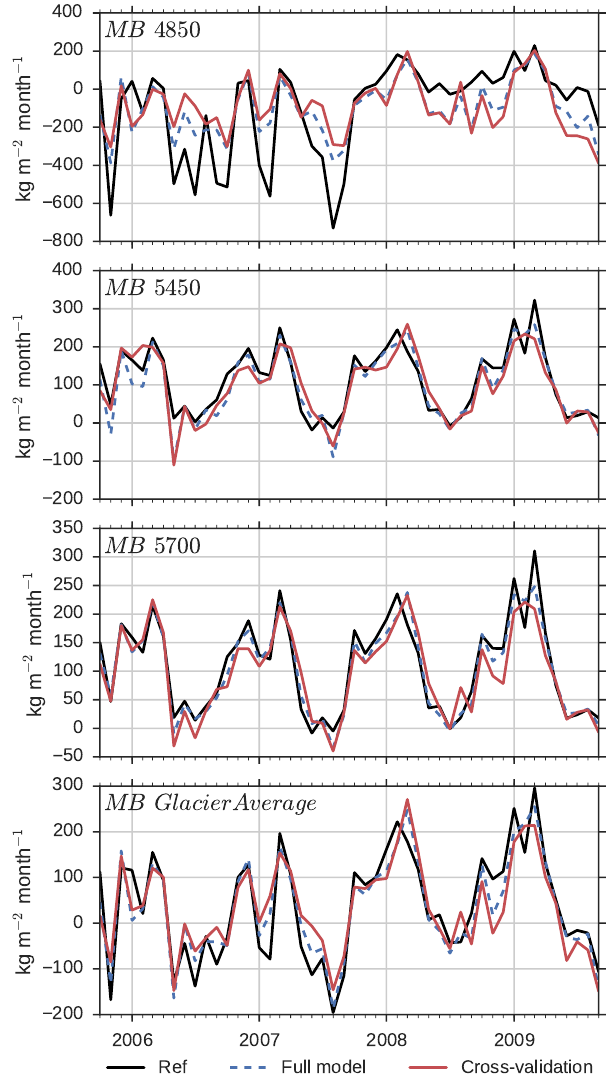
Figure 10. Time series of the reference data set (black), full down- scaling model (dotted, blue) and out-of-sample cross–validation (red) during the calibration period. Shown are the mass balance time series at the 4850, 5450 and 5700ma . s . l . altitude slices and averaged over the whole